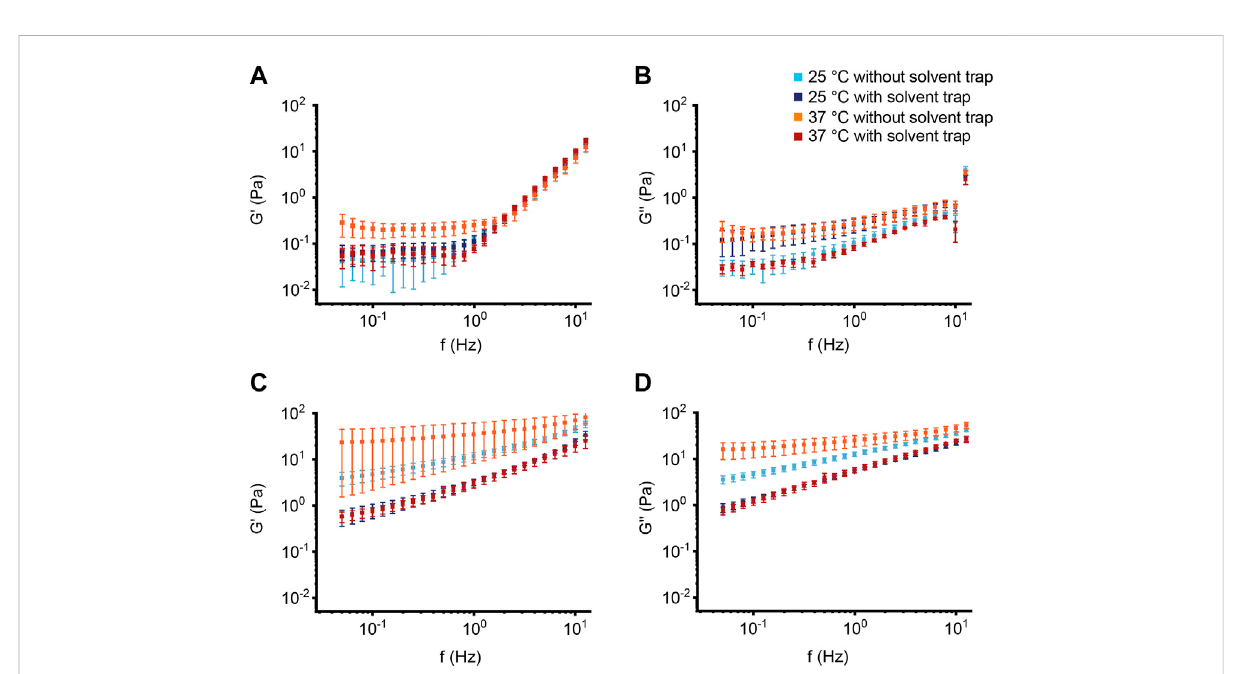
FIGURE 2 Effectofmucinconcentration,measurementtemperatureandevaporationcontrolonmacrorheologyofthebovinesubmaxillarymucinmucus model system. (A,C) Storage modulus G ′ and (B,D) loss modulus G ″ of (A,B) 2% ( n = 5) and (C,D) 10% ( n = 5) bovine submaxillary mucin were measured as function of frequency (Hz). Data are shown as mean ± standard error of the mean (SEM) of measurements at 25 ° C and 37 ° C with and without solvent